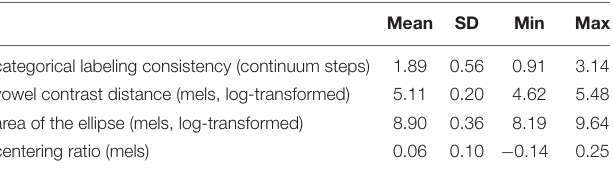
TABLE 1 | Summary of descriptive statistics (i.e., mean, standard deviation, minimum and maximum values) for each of the measures ( n = 31).